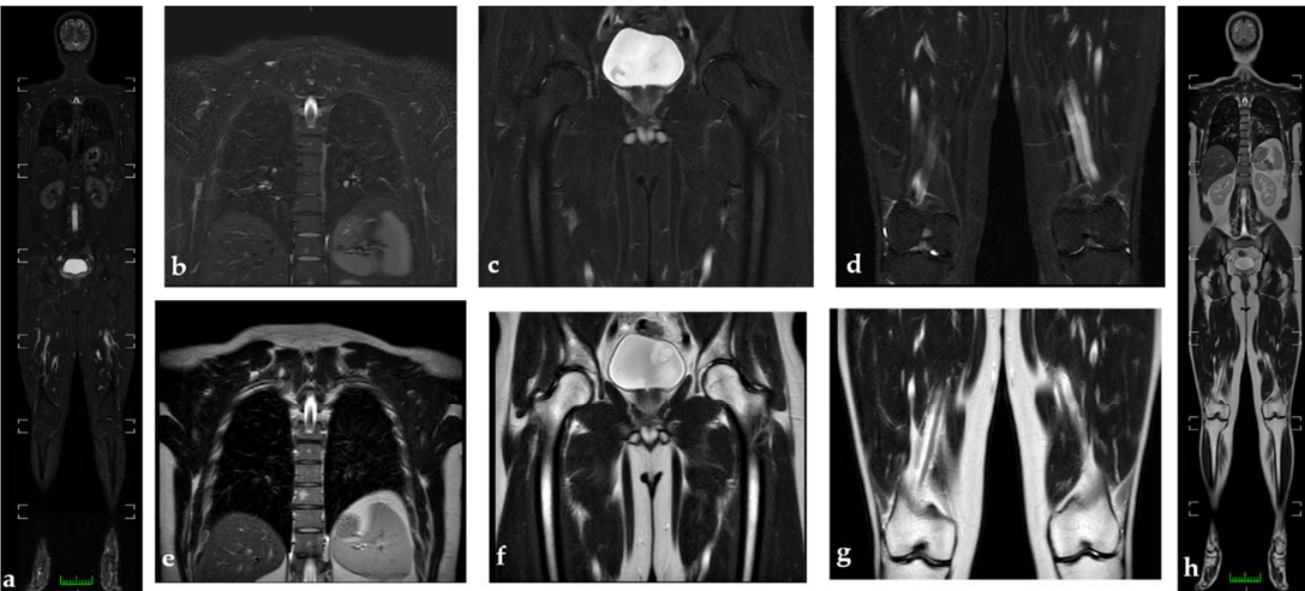
Figure 2. WB-MRI to study a 30-year-old man ( a ). WB-MRI coronal STIR images do not show active inflammation consisting of synovitis or tenosynovitis, and pathological findings appear to be better visualized than in WB-MRI coronal T2 ( h ). ( b – d ) represent coronal STIR images, while ( e – g ) represent coronal T2 images at the level of the thoracolumbar spine; the hip and knees do not show the pathological hyperintensities or hypointensities of the signal in the osteoarticular structures under examination. ( e ) Hyperintensity in t2 at the level of the soma of a thoracic vertebra with isointenity in stir ( b ); findings compatible with angioma.